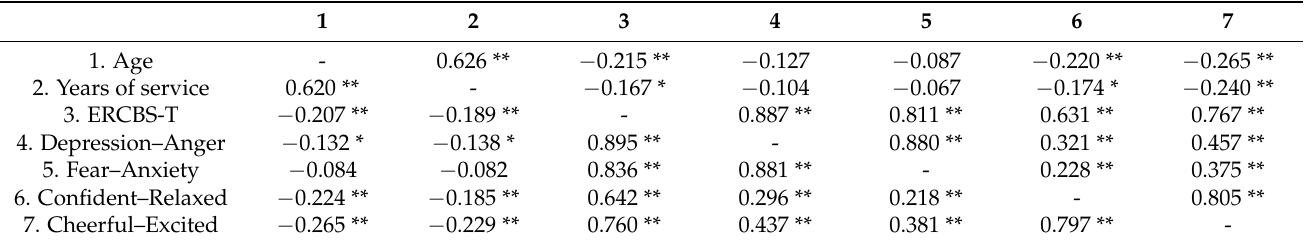
Table 4. Correlations for age, years of service, ERCBS-T and ERCBS